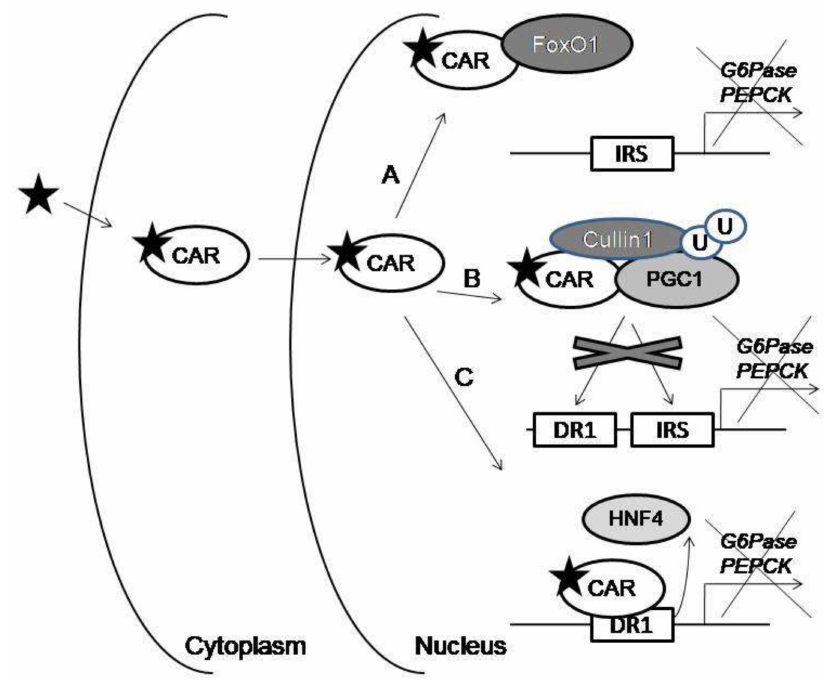
Figure 1. Noncanonical mechanisms of the constitutive androstane receptor (CAR)-mediated suppression of gene expression. When CAR interacts with a ligand in the cytoplasm, CAR translocates to the nucleus. ( A ) Activated CAR binds to forkhead box O1 (FoxO1), thereby blocking its interaction with the insulin-responsible sequence (IRS) in the gene promoters. ( B ) Activated CAR serves as an adapter protein for the recruitment of Proliferator-activated receptor Gamma Coactivator-1 alpha (PGC1 α ) into the complex with E3 ligase Cullin1, where PGC1 α undergoes ubiquitination and subsequently, proteasome degradation. ( C ) Activated CAR competes with hepatic nuclear factor-4 α (HNF4 α ) for binding to